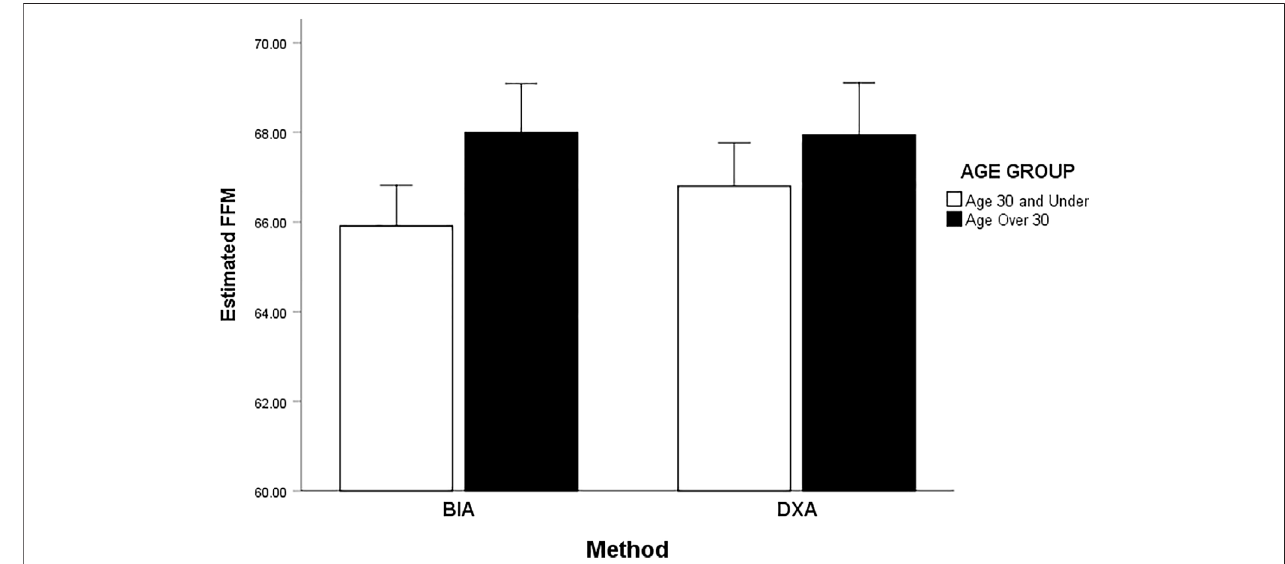
FIGURE 5 | Interaction effect of FFM by age and method BIA and DXA for men ( ≤ 30 and > 30).